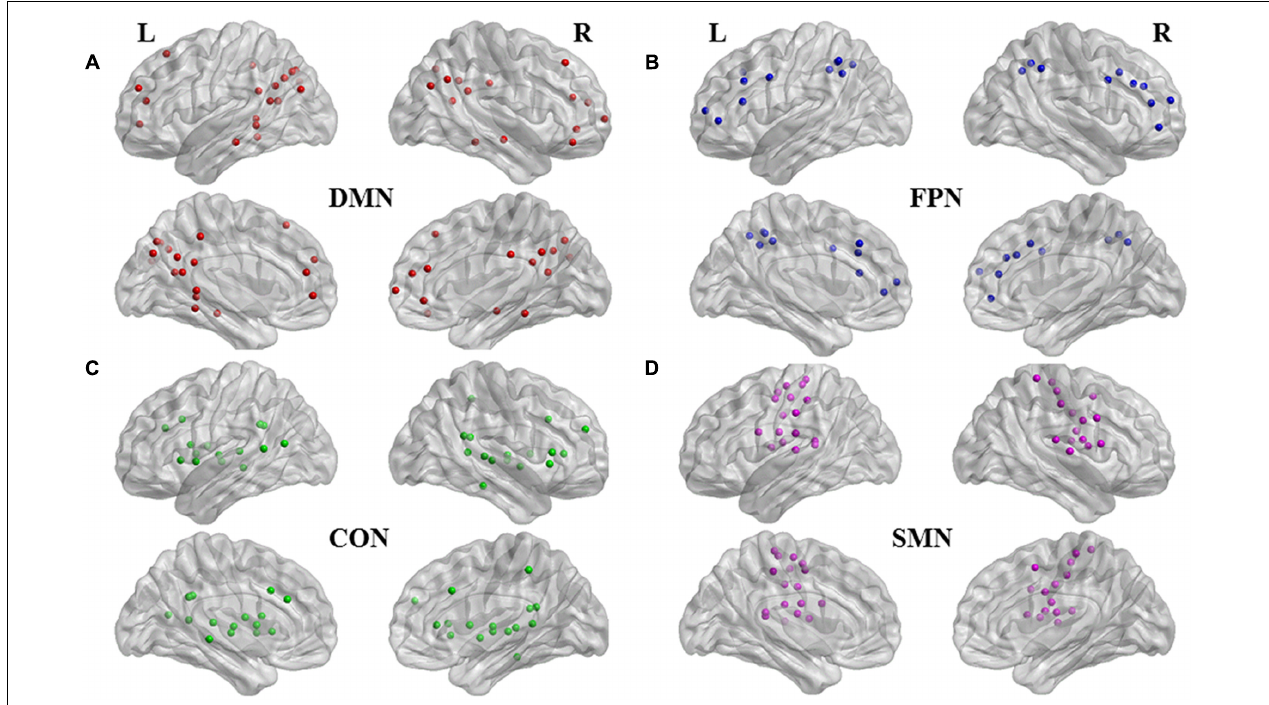
FIGURE 1 | Functional nodes investigated. Medial and lateral views of brain images with 120 regions of interest of four subnetworks (Dosenbach et al., 2010). (A) 34 nodes in red are affiliated with default mode network (DMN); (B) 21 nodes in blue, with fronto-parietal network (FPN); (C) 32 nodes in green, with cinculo-opercular network (CON); and (D) 33 nodes in purple, with sensorimotor network (SMN). Brain image and nodes are visualized using the BrainNet Viewer (NKLCNL, Beijing Normal